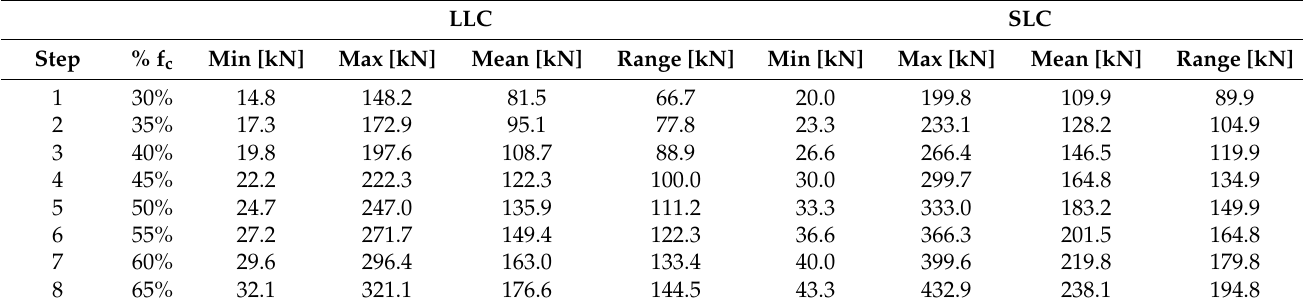
Table 4. Applied loads in each step of the Locati fatigue